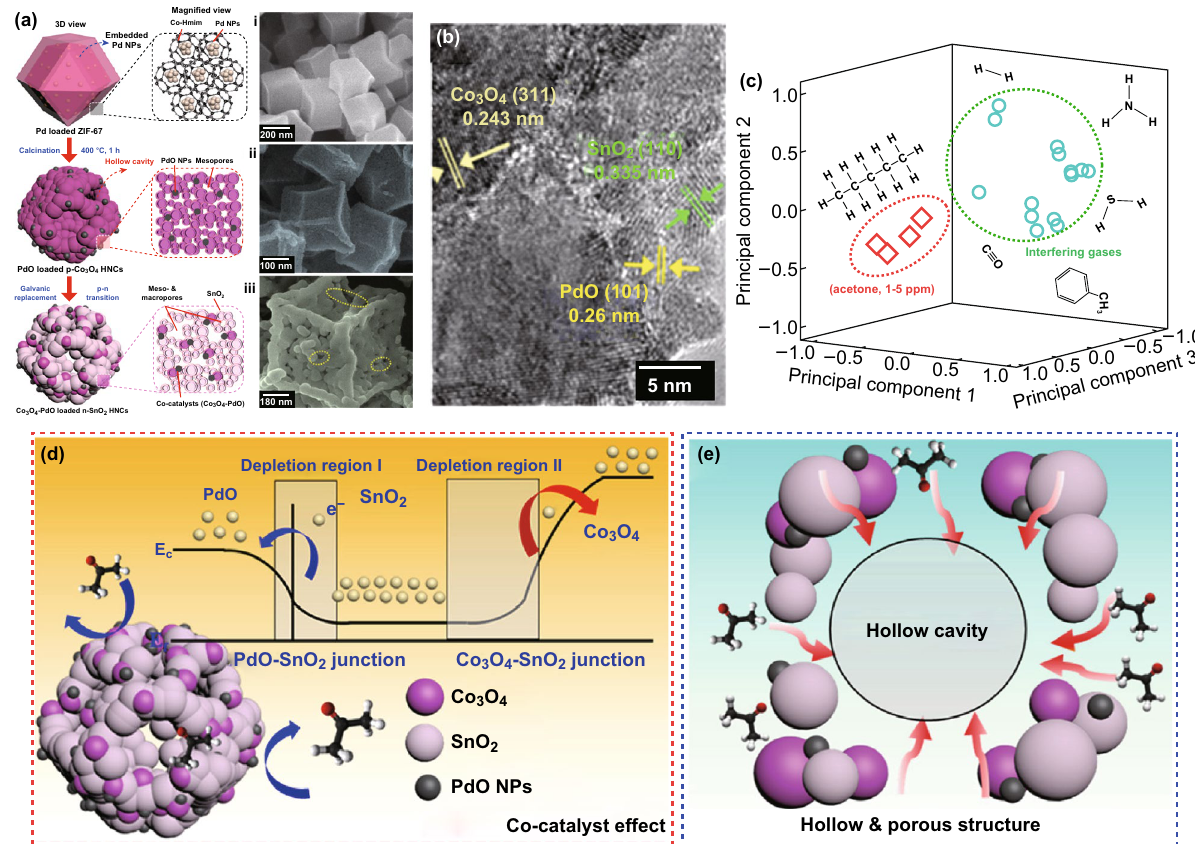
Fig. 19 a Schematic illustration and SEM images of synthetic process for the n-SnO 2 HNCs functionalized with Co 3 O 4 and PdO. b HRTEM lat- tice spacing image of SnO 2 –PdO-loaded p-Co 3 O 4 HNCs. c Pattern recognition based on PCA using sensor arrays (Co 3 O 4 -loaded n-SnO 2 HNCs and